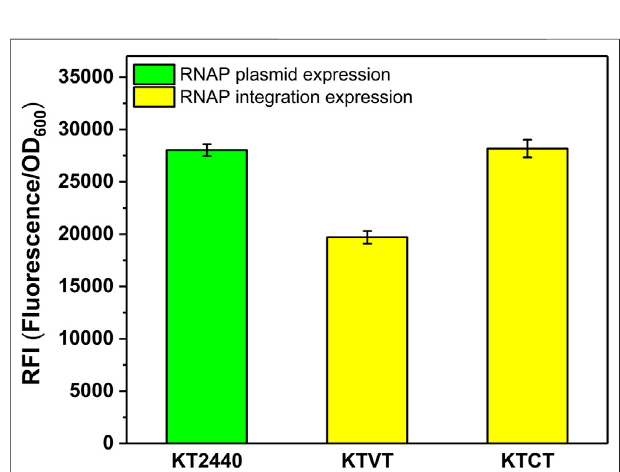
FIGURE 5 | RFI of the T7 RNAP cassette integrated into P. putida KT2440 with different integration sites. KT2440: KT2440 harboring the plasmid containing the T7 RNAP module and sfGFP with T7 promoter; KTVT: KTVT with T7 RNAP cassette integrated into vdh site of KT2440 harboring the plasmid containing sfGFP with T7 promoter; KTCT: KTCT with T7 RNAP cassette integrated into phaC1 site of KT2440 harboring the plasmid containing sfGFP with T7